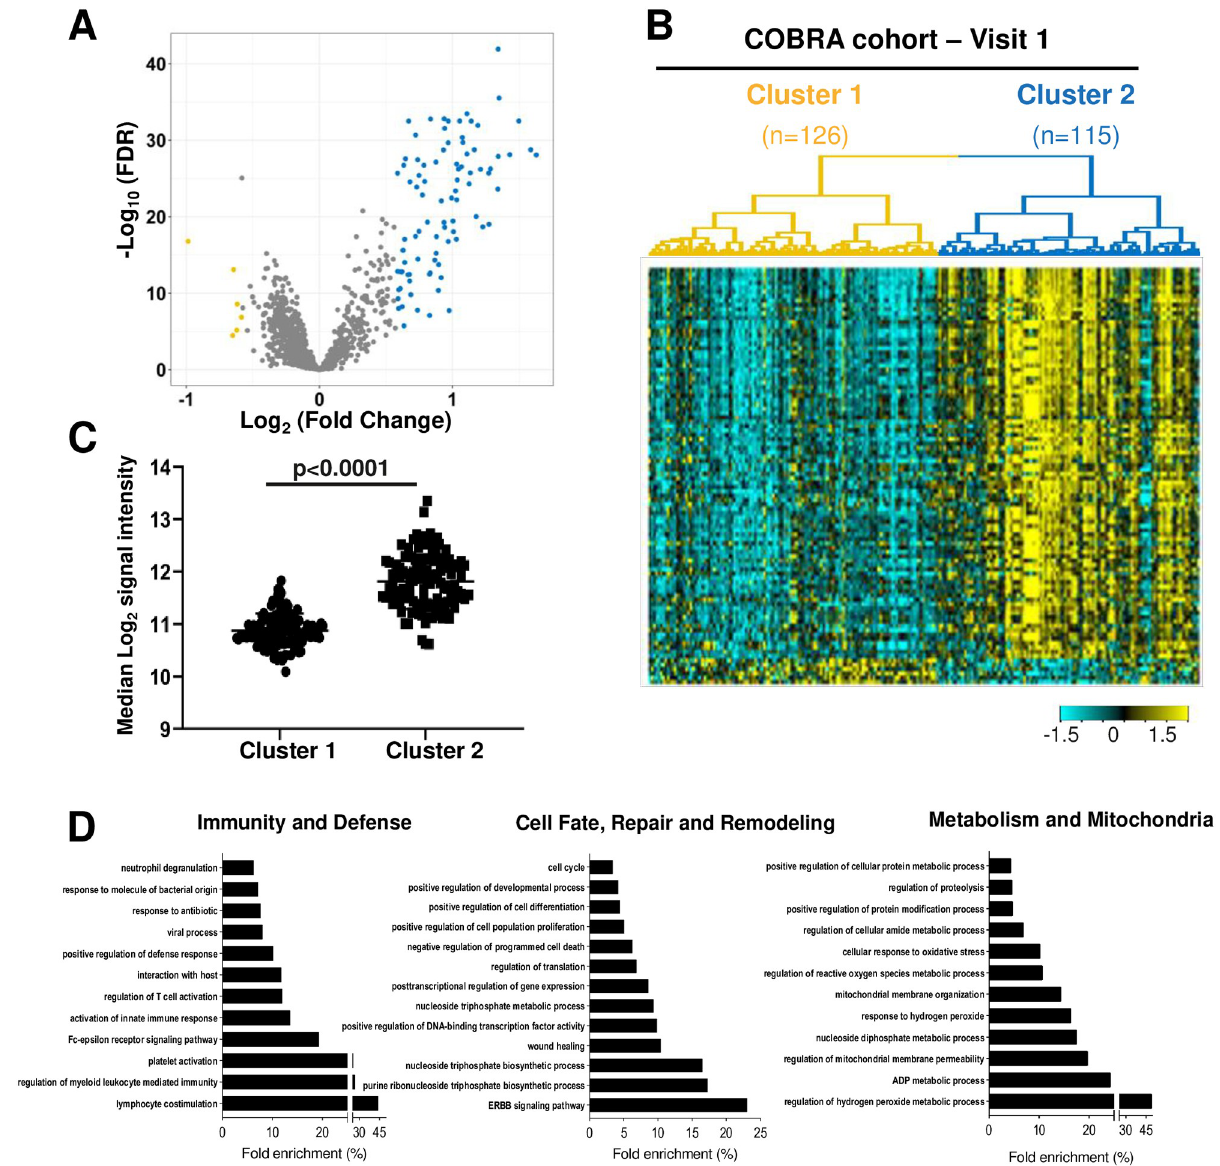
Fig 2. Two COPD patient Clusters show differentially expressed proteins enriched for distinct biological pathways. (A) Volcano plot showing differentially expressed proteins between Cluster 1 and Cluster 2. X axis corresponds to log2 (fold change) and Y axis corresponds to -log10 (FDR). Yellow indicates proteins with significant downregulation and blue indicates those with significant upregulation (Fold change > 1.5 and FDR < 0.05 for both comparisons); (B) Heatmap showing the expression pattern of differentially expressed proteins between the two clusters. (C) Median expression of 90 proteins associated with Cluster 2; (D) Top GO pathways comparing Cluster 2 versus Cluster 1, regrouped in three core functions defined as “Immunity and defense”, “Cell fate, repair and remodeling”, and “Metabolism and